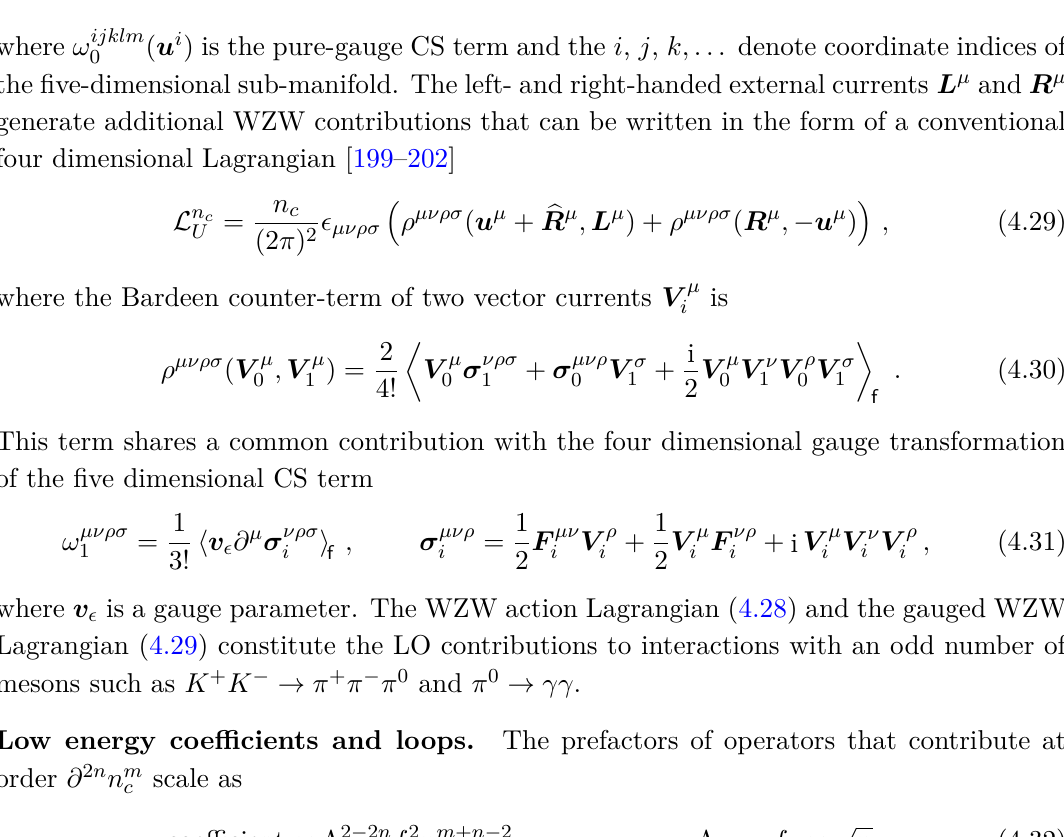
Table 9. NDA and large n c scaling of selected coefficients that appear in the order δ 2 and δ 3 Lagrangians. Additionally, we have made the omitted symmetry factors